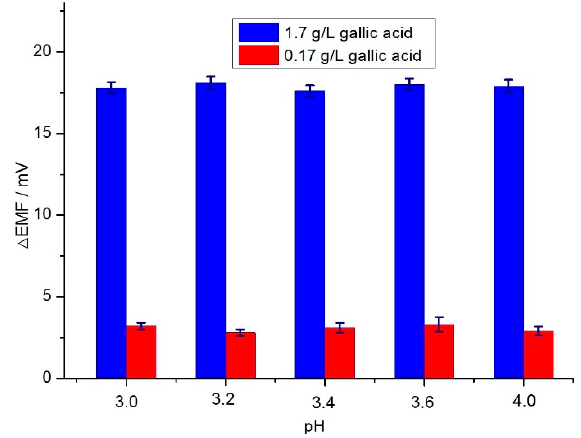
Figure 4. The influence of pH on the response performance of the proposed potentiometric sensor.